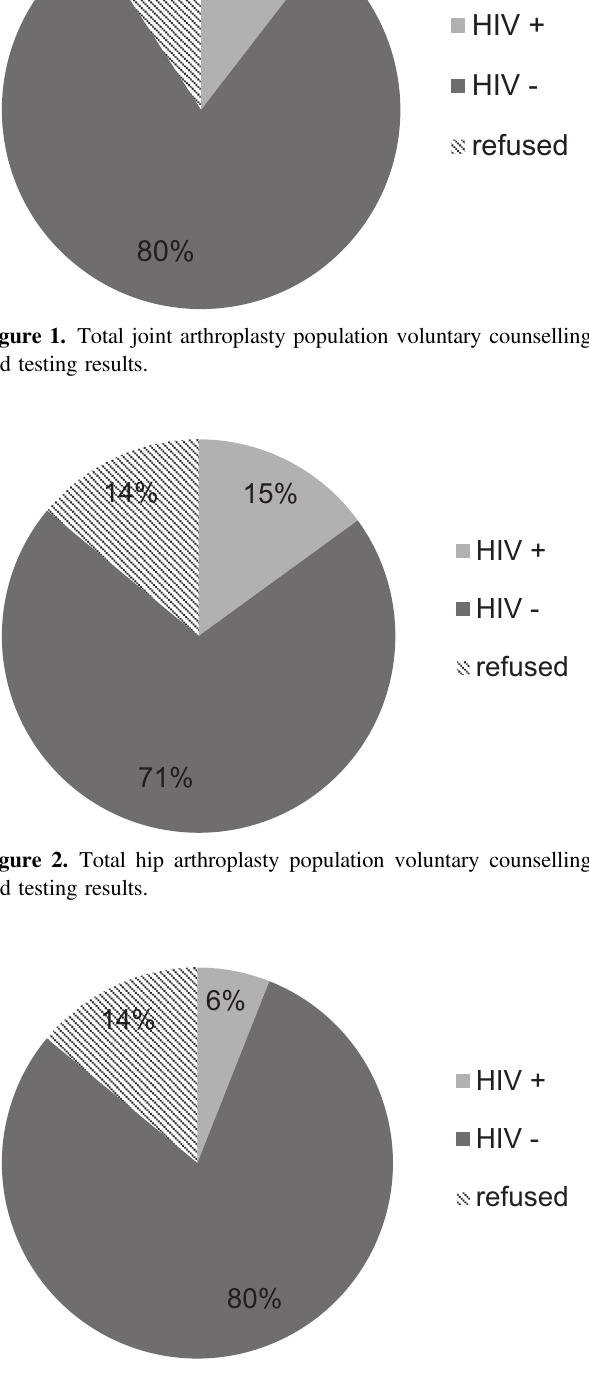
Figure 3. Total knee arthroplasty population voluntary counselling and testing